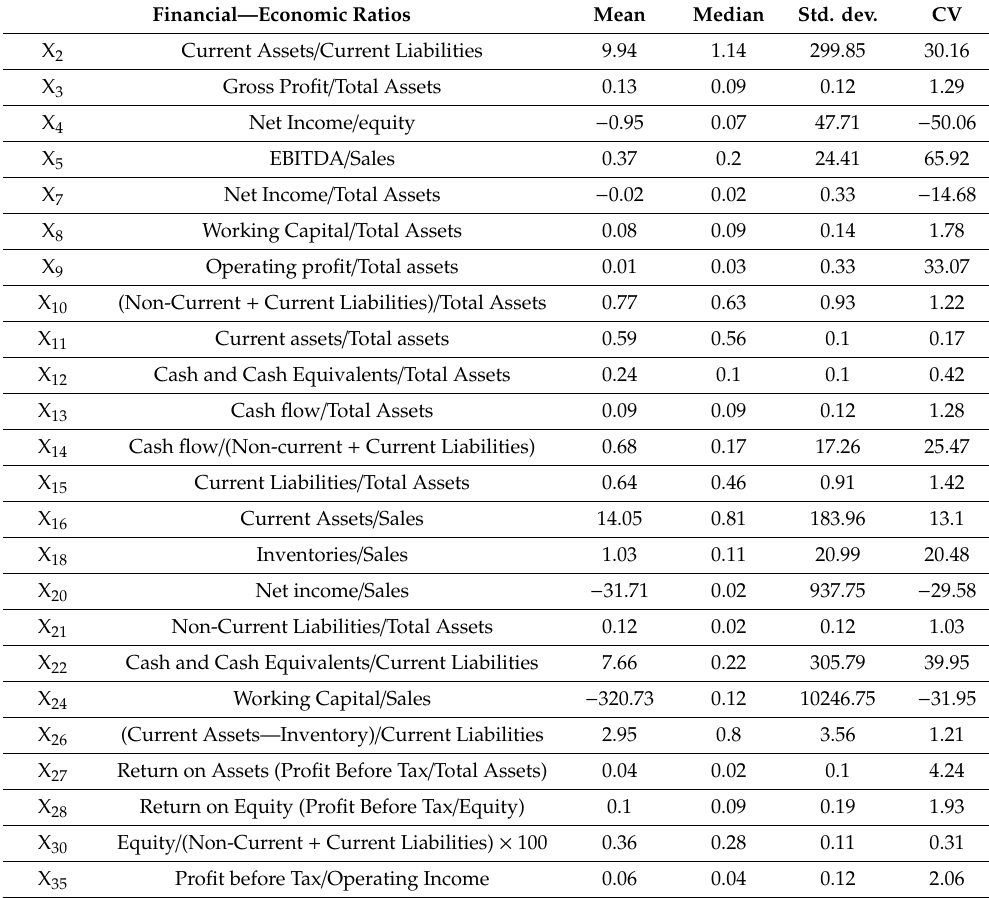
Table 2. Descriptive statistics of financial-economic